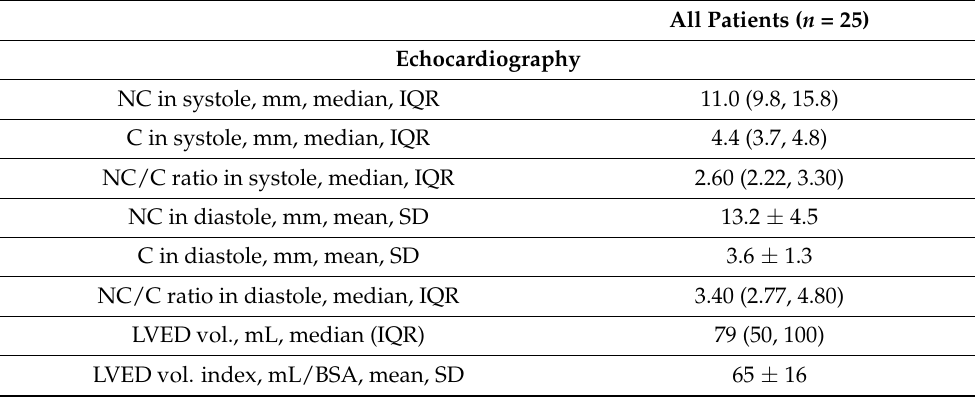
Table 2. Echocardiographic and CMR imaging